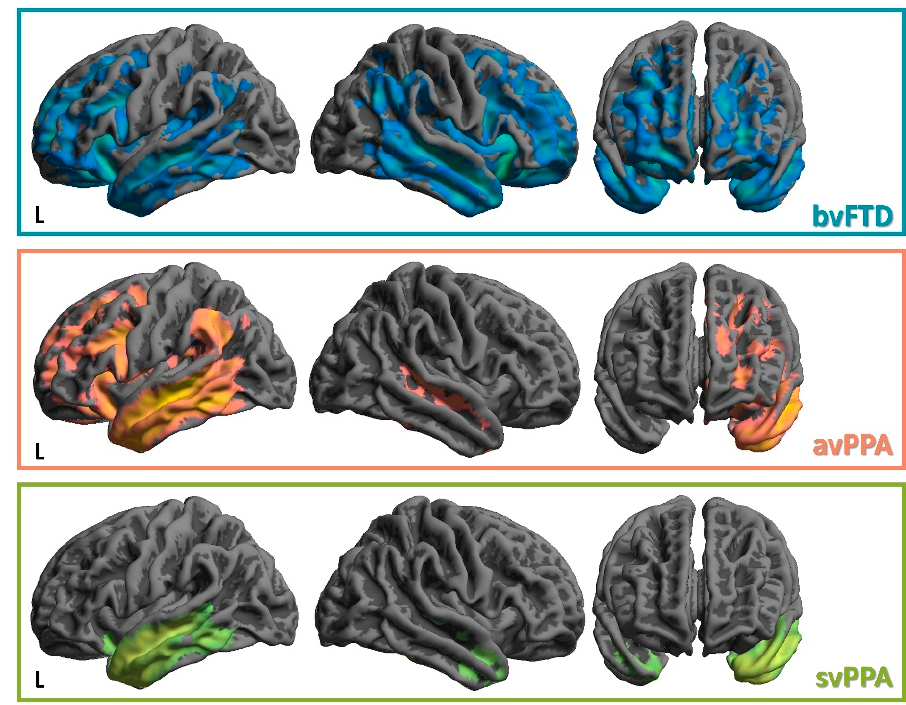
Figure 2. Representative VBM analysis in FTLD. From our historical cohort of FTLD patients we performed a structural MRI analysis (voxel-based morphometry) to demonstrate the different patterns of gray matter atrophy. To this aim, we considered the following cohort of subjects (80 healthy controls (63.1 ± 7.9 years, 75% females); 122 bvFTD (64.8 ± 7.9 years, 38% females): 68 avPPA (65.6 ± 8.4 years, 66.2% females); 30 svPPA (63.6 ± 8.4 years, 56.7% females). Age and gender are considered nuisance variables in the statistical model. The findings (patient < healthy controls for each group) are superimposed on a 3D MRI template; clusters surviving a statistical threshold of p < 0.05 FWE whole-brain correction for multiple comparisons are reported. VBM—voxel-based morphometry; MRI—magnetic resonance imaging; FWE—family-wise error; L—left. Brain FDG-PET shows areas of hypometabolism that reflect atrophic regions, but might be more sensitive than structural images in the initial stages of the disease [28,29].